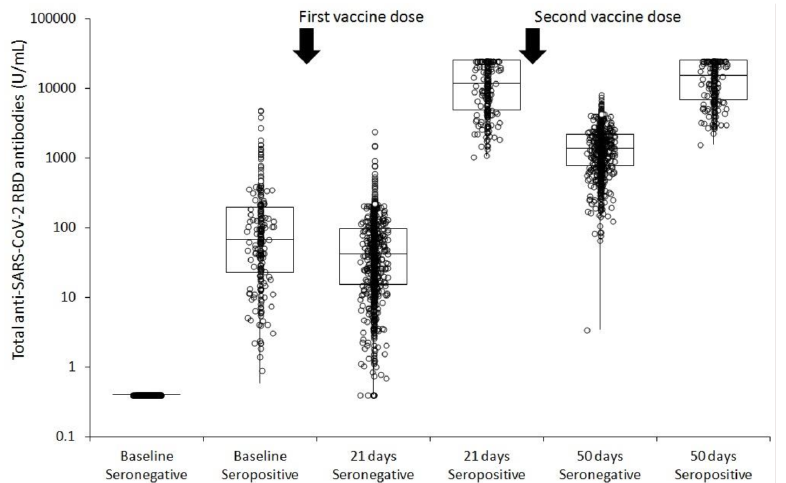
Figure 1. Total anti-SARS-CoV-2 RBD antibodies in seronegative (<0.8 U/L) or seropositive ( ≥ 0.8 U/L) subjects at baseline and after receiving a complete cycle (i.e., two doses) of Pfizer COVID-19 mRNA BNT162b2 vaccine.